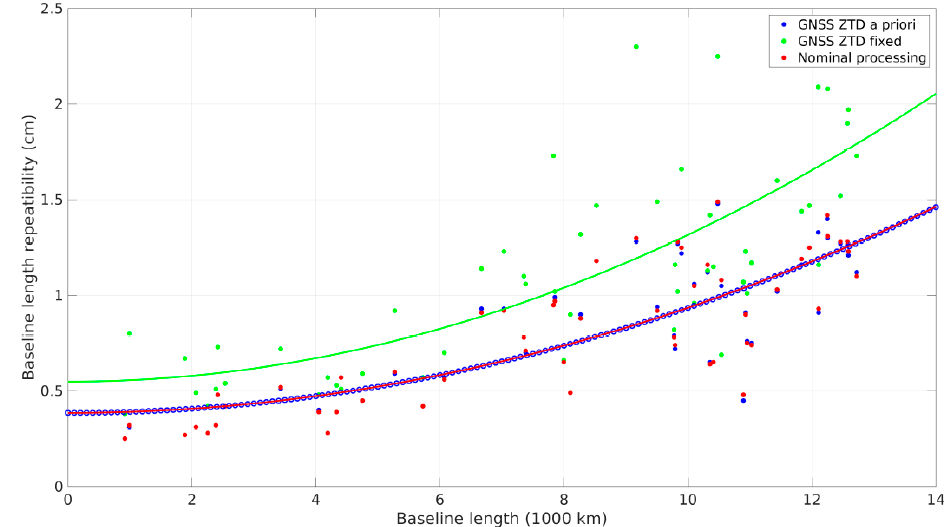
Figure 2. Baseline length repeatabilities in CONT17 campaign under different troposphere estimation